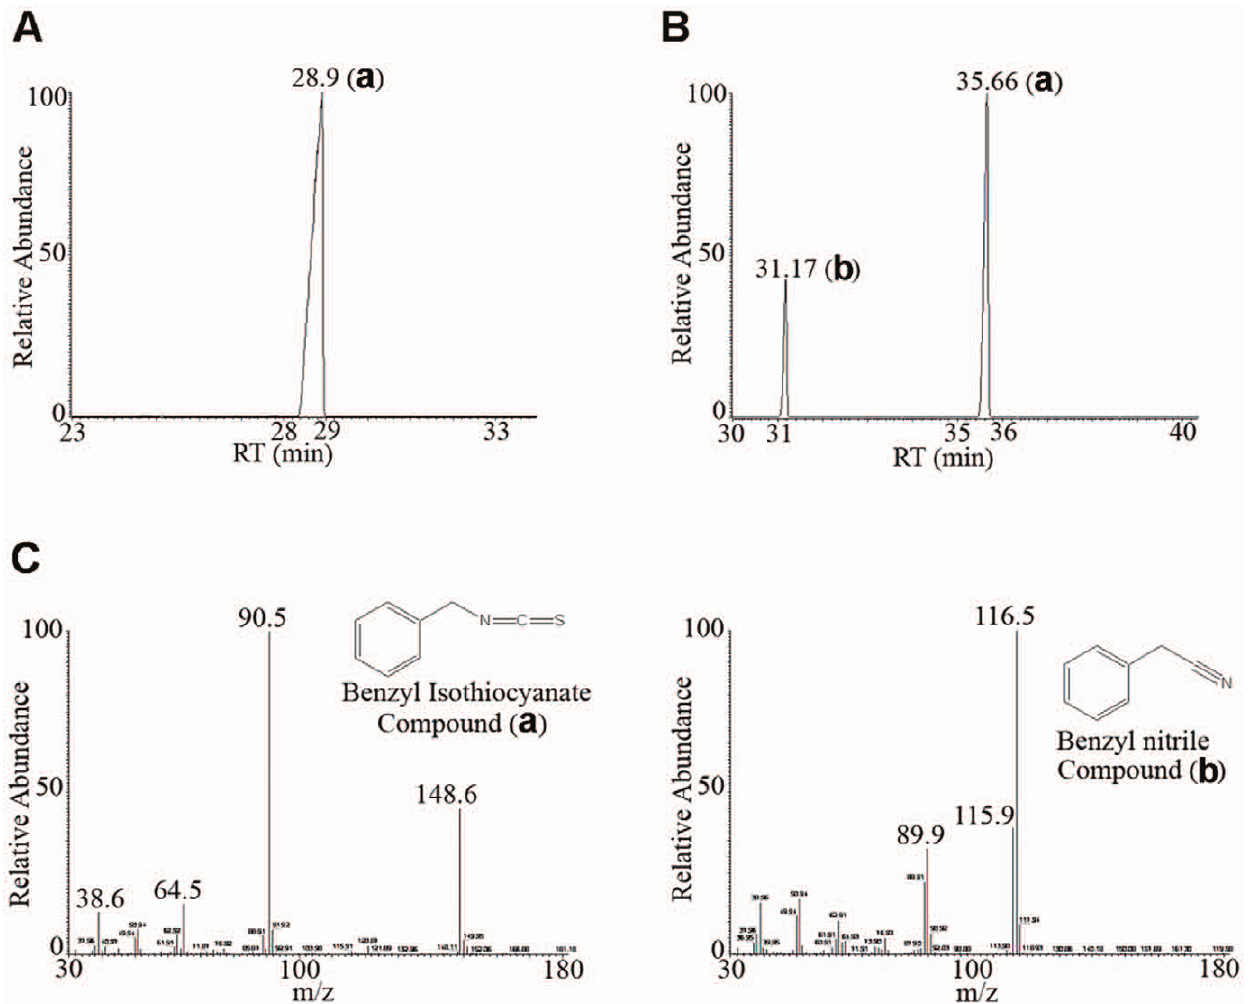
Figure 2. Gas chromatography-mass spectrometry (GC-MS) analysis of S.persica root volatiles and essential oil. (A) Chromatogram of Miswak volatiles (B) Chromatogram of Miswak essential oil. (C) Mass spectrometry (MS) analysis and identification of compound a as benzyl isothiocyanate MW=148.6 (theoretical mass 149.21) and compound b as benzyl nitrile, MW=116.5 (theoretical mass 117.15). The chemical structures are presented as insets in the figure.